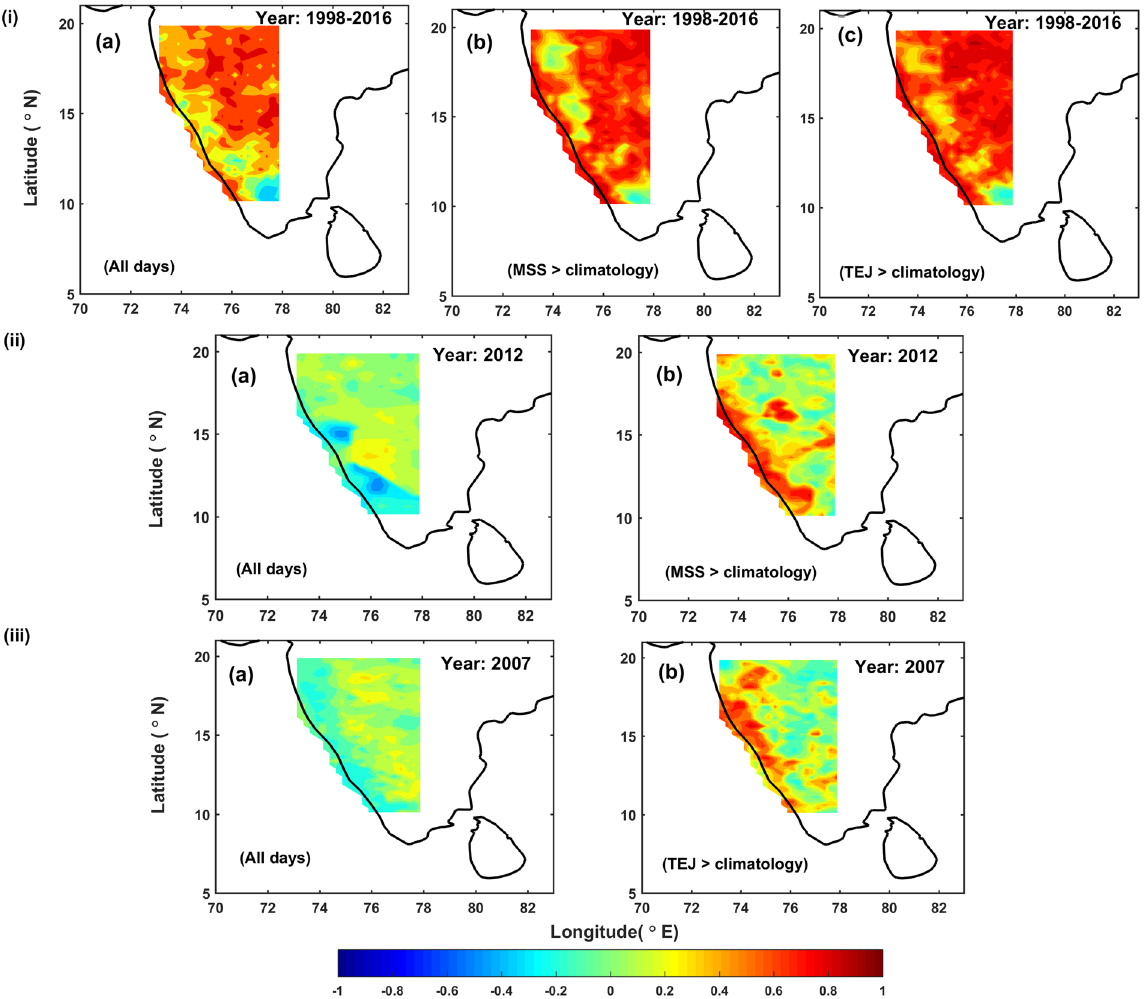
Figure 5. Spatial pattern of temporal correlation during SW monsoon (i) ( a ) for all 122 days, for the days when ( b ) MSS > climatology and ( c ) TEJ > climatology from 1998 to 2016,(ii) for the year 2012 same as (i) ( a,b ) (iii) for the year 2007 same as (i) ( a , c